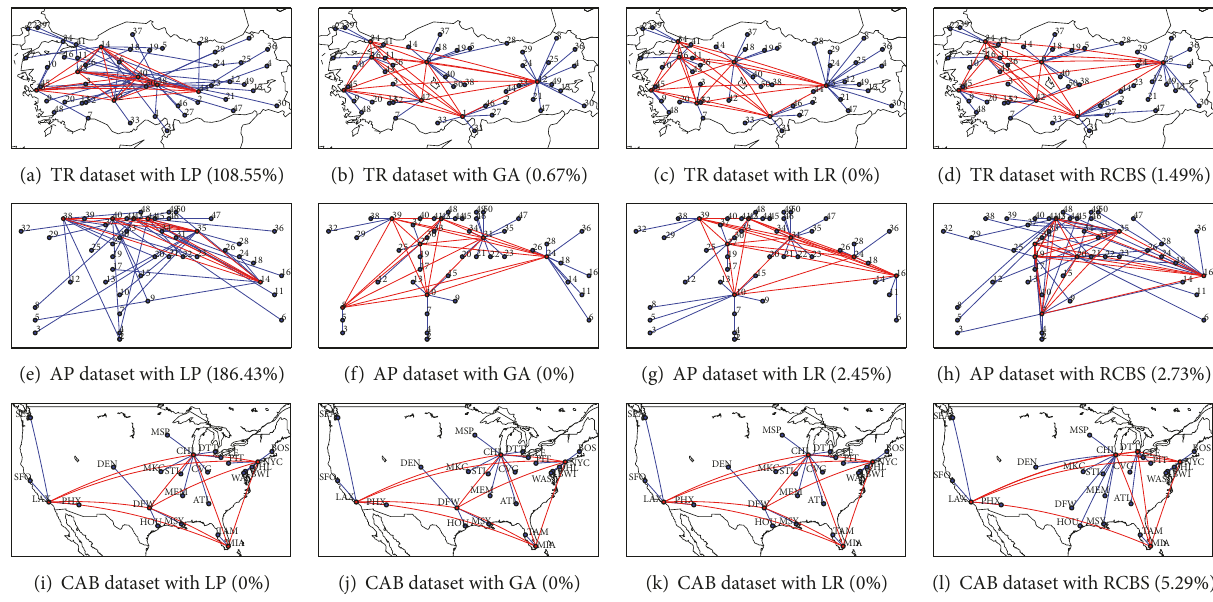
Figure 9: Visualization of CSA problems for the TR dataset with 𝑛 = 50 , 𝑝 = 7 , and 𝛼 = 0.5 , AP dataset with 𝑛 = 50 , 𝑝 = 7 , and 𝛼 = 0.75 , and CAB dataset with 𝑛 = 25 , 𝑝 = 5 , and 𝛼 = 0.5 : red points are hubs and blue points are nonhub nodes. The red links are hub links. For the TR dataset, CPLEX-LP provides a feasible solution only, and therefore the assignment is rather useless. The results obtained by GA, LR, and RCBS are quite similar to each other. For the AP dataset, CPLEX-LP and RCBS provide poor solutions, while the results of GA and LR are different regarding one hub. For the CAB dataset, CPLEX-LP, GA, and LR are all up to the optimality, while RCBS selects Detroit (DTT) as a hub because of its high node importance instead of Dallas